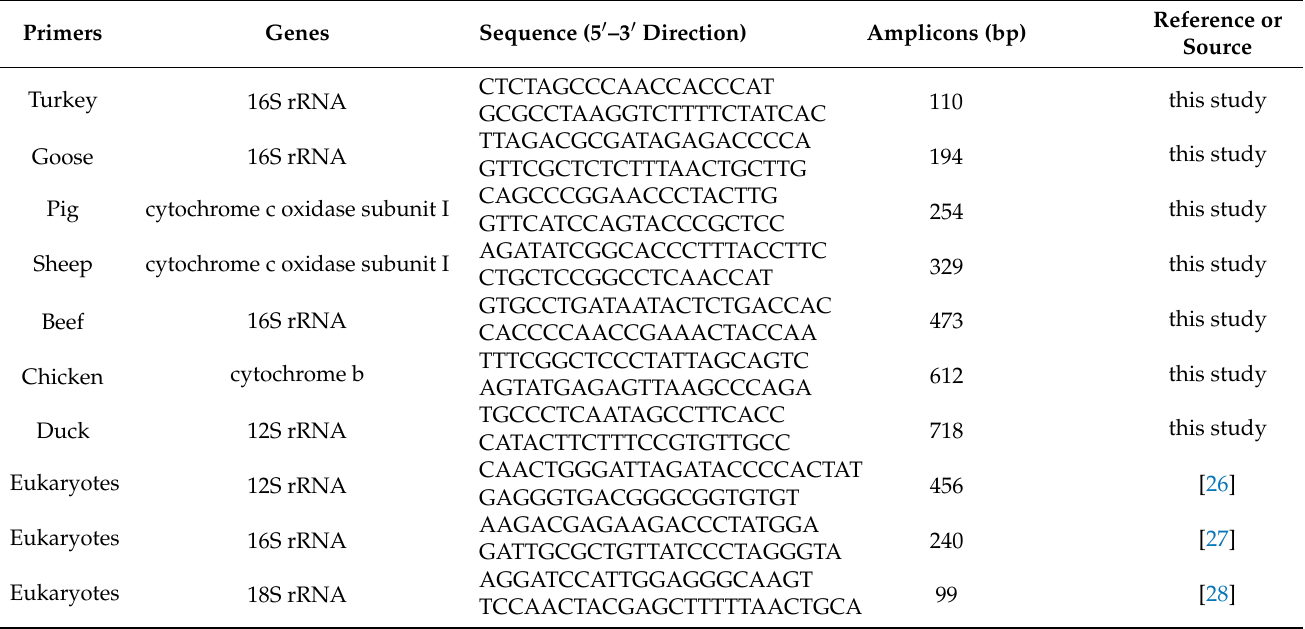
Table 1. Oligonucleotide primers for meat species used in this